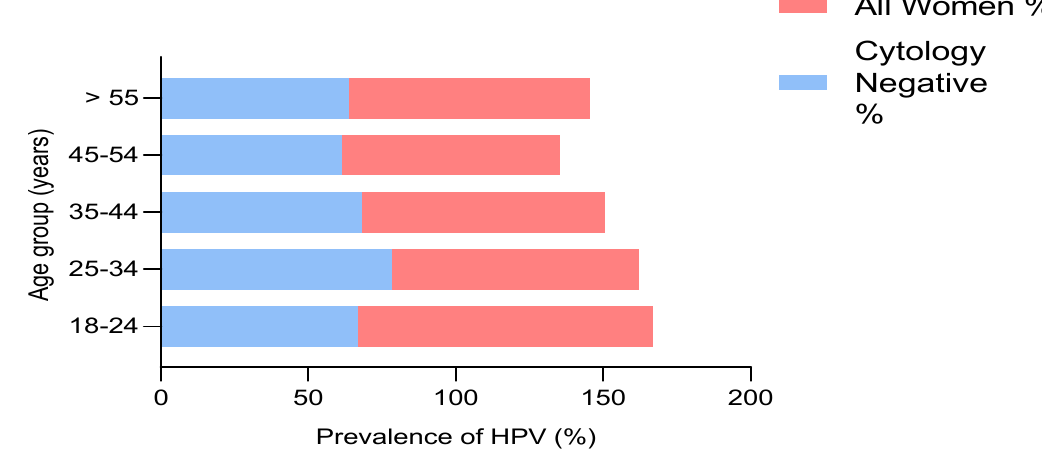
Figure 1. Age-specific detection of HPV DNA among all participants and cytology-negative women. The highest prevalence among all women was reported in the age group of 18–24 years, while the age group of 45–54 years had the lowest prevalence. HPV prevalence was high among cytology-negative women between the ages of 25 and 34 compared to the age group of 45–54 which had the lowest prevalence of all groups.